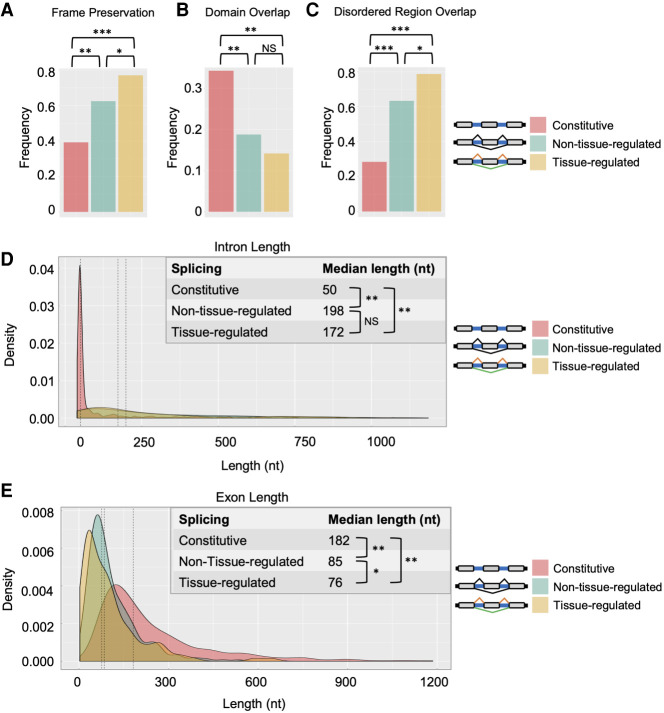
Features associated with alternative exons and tissue-regulated alternative exons. For panels A–E, comparisons were made between constitutively spliced exons (pink), alternative exons (light blue), and tissue-regulated alternative exons (gold). (A) Comparison of frequency of frame preservation (percentage of exons that are a multiple of 3 nt). (B) Frequency of exons overlapping with a UniProt conserved protein domains. (C) The frequency of exons overlapping with predicted disordered regions in proteins. (D) Distributions of the lengths of introns flanking internal exons from same comparison groups. (E) Distribution of the lengths of exons. (A,C) Pearson's chi-squared test: (*) P ≤ 0.01; (**) P < 1 × 10−3; (***) P < 1 × 10−10. (D,E) Wilcoxon rank-sum test: (*) P ≤ 0.05; (**) P < 1 × 10−15.